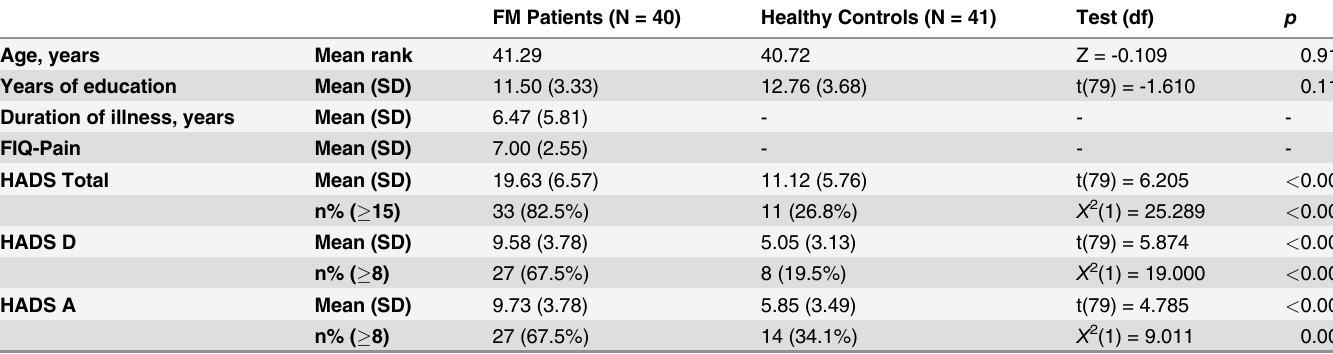
Table 1. Demographic, clinical and psychological characteristics of the FM and HC groups. FM Patients (N =